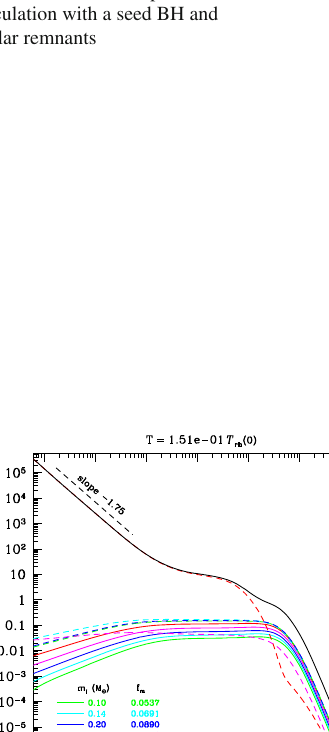
Fig. 36 Lagrange radii evolution for a 10 components calculation with a seed BH and stellar remnants